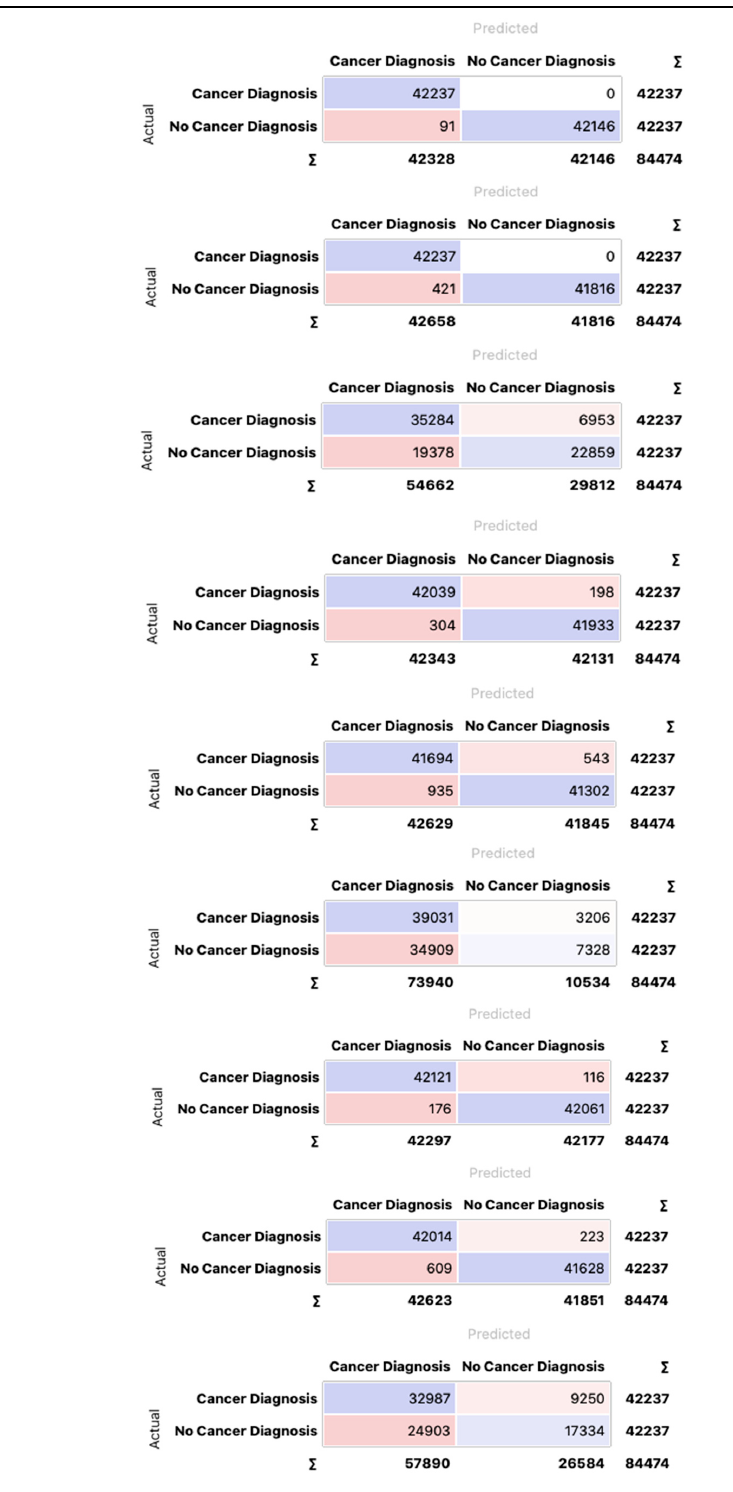
Table 9. Confusion matrix of the fusion model for datasets balanced using oversampling techniques.